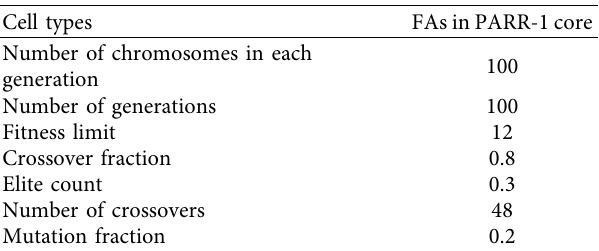
Figure 5: The flow chart of the modified genetic algorithm. Table 4: Parameters used in MGA